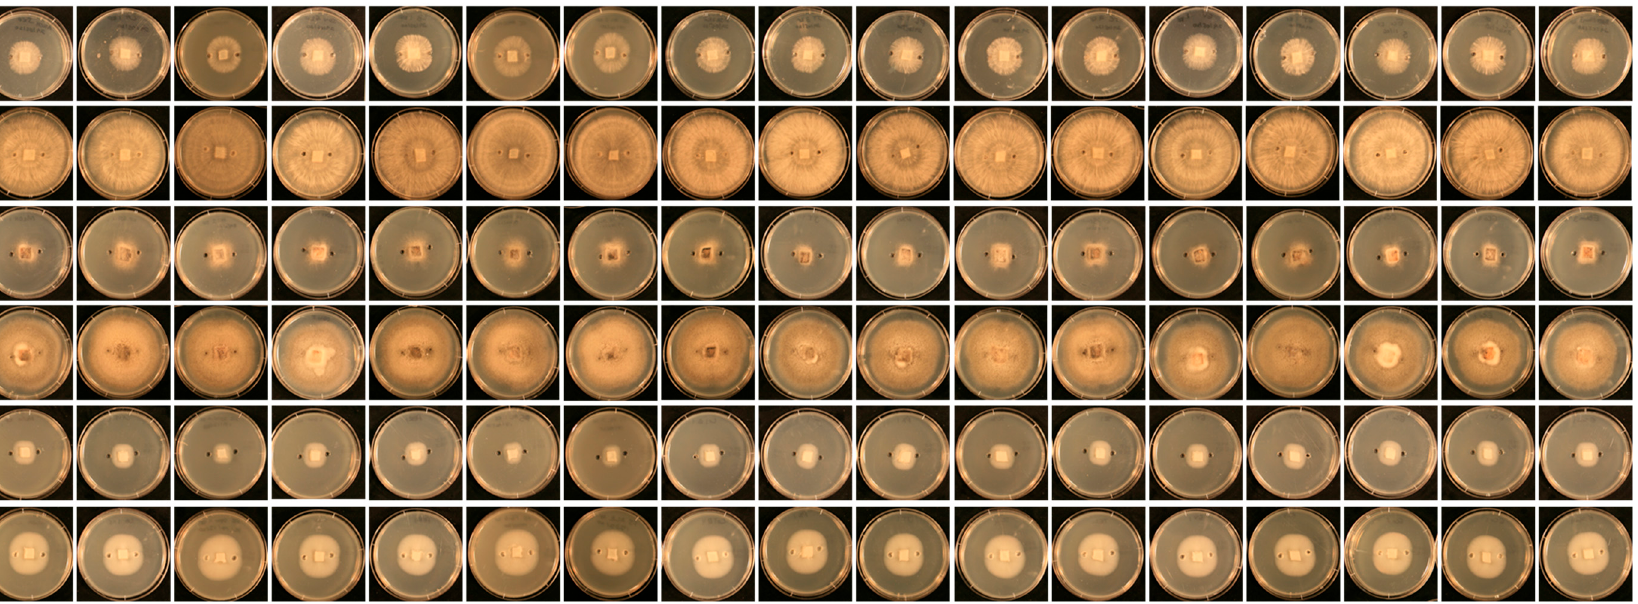
Figure 1. Optimised agar-well diffusion assay for growth inhibition of pathogens Ceratobasidium sp., Drechslera sp. and Fusarium sp. by thirteen alkaloids and controls (in columns); carbendazim, 80% methanol (MeOH), 1% lactic acid, 16% hydrochloric acid (HCl), sterile distilled water (SDW), peramine hemisulfate (peramine), n -acetylloline.HCl (acetylloline), n -formylloline (d3) (formylloline), lolitrem B, janthitrem A, paxilline, terpendole E, terpendole C, ergovaline, ergotamine, ergocornine, ergocryptine, ergotaminine. Observations on days three and six (in rows) of the bioassay images are typical representatives of the five replicates.